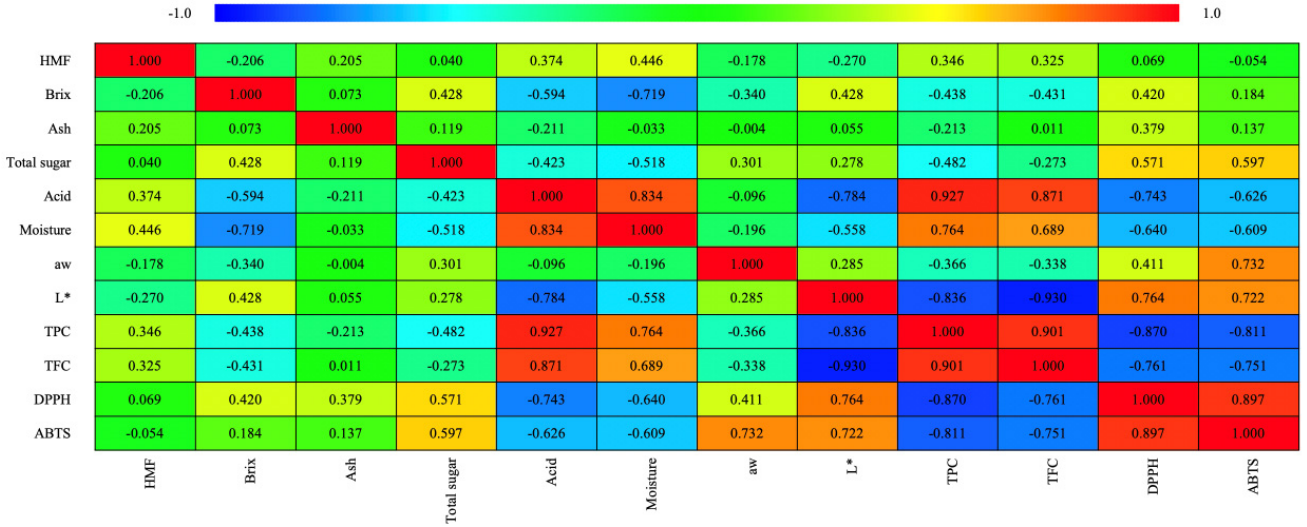
Figure 4. Correlation coefficients for antioxidant capacity versus TPC, TFC and physicochemical properties of honey. properties of